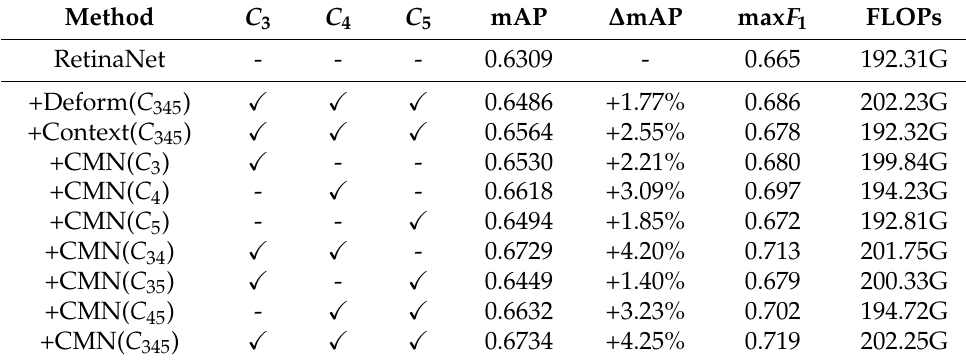
Table 1. Adding CMN for feature